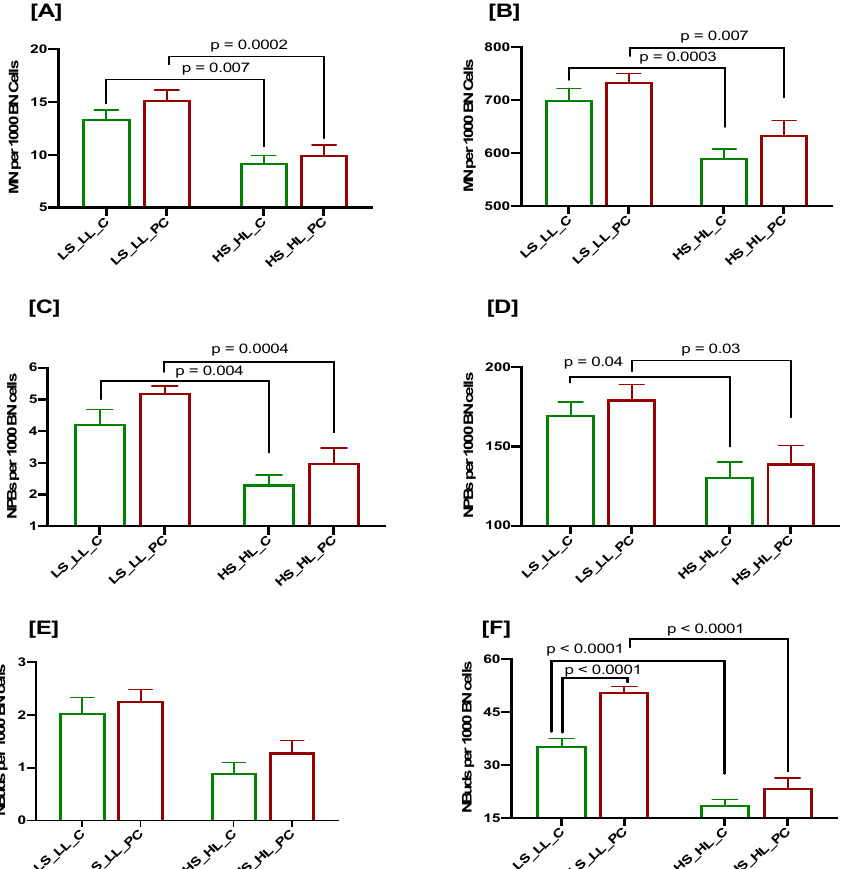
Figure 4. CBMN Cytome assay biomarkers in PC patients (red bars) and age-matched healthy control (green bars) stratified as per selenium and lycopene concentrations (LS: low selenium; HS: high selenium; LL: low lycopene; HL: high lycopene); MN frequency at baseline ( A ) and after 3 Gy irradiation ( B ); NPBs at baseline ( C ) and after 3 Gy irradiation ( D ); NBuds at baseline ( E ) and after 3 Gy irradiation ( F ). N = 29, 34, 52 and 28, respectively, from left to right for each bar. p values are only indicated for those comparisons that are significant.